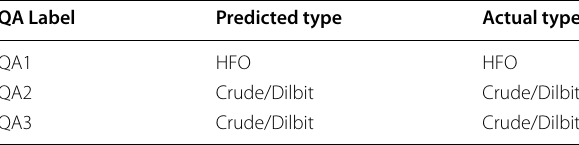
Table 3 Summary of final oil type classifications of quality assurance